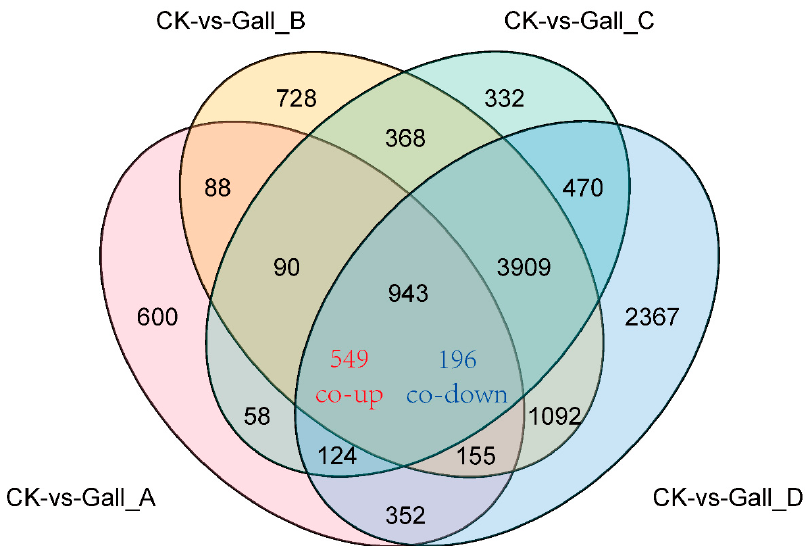
Figure 3. A Venn diagram comparing significantly different expressed genes at different gall-formation stages.